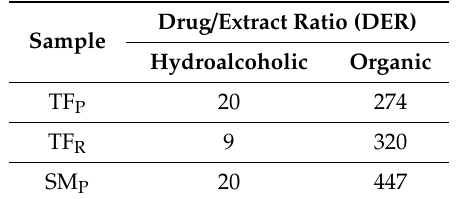
Table 1. Drug to extract ratio of Bligh–Dyer (hydroalcoholic and organic) extracts of both pink and red fruits from Solanum lycopersicum var. Torpedino di Fondi (TF) and San Marzano (SM) a . Drug / Extract Ratio Sample